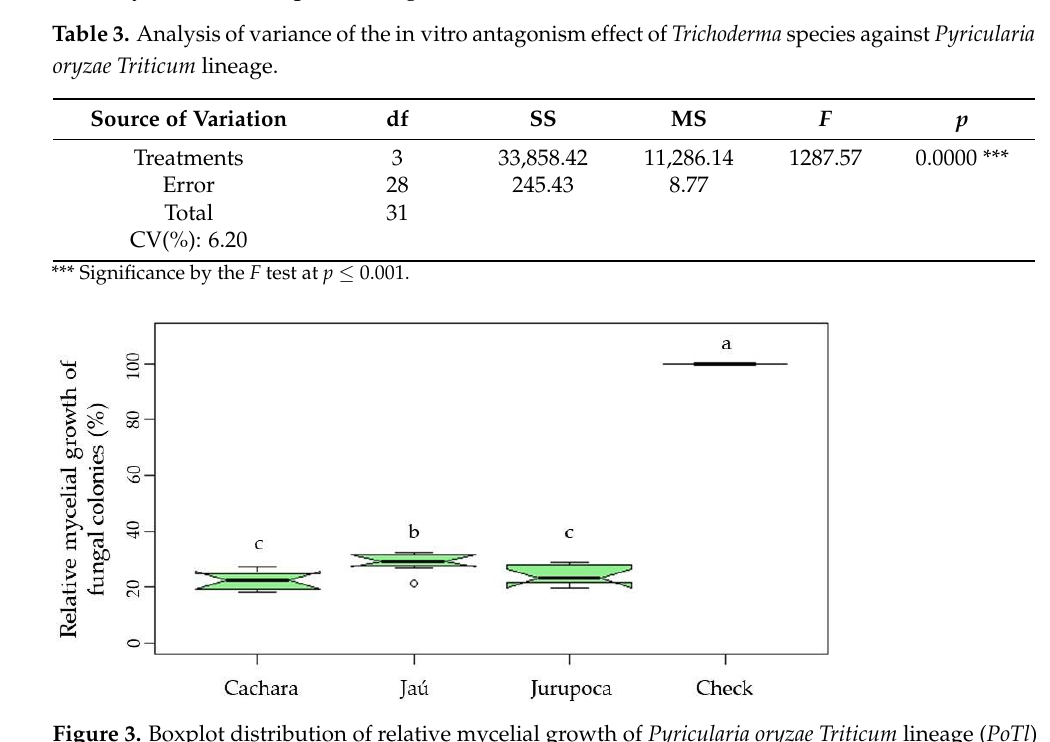
Table 3. Analysis of variance of the in vitro antagonism effect of Trichoderma species against Pyricu- laria oryzae Triticum lineage.